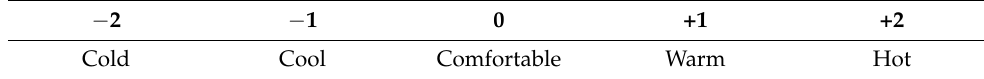
Table 1. Adopted Thermal Sensation Vote scale.